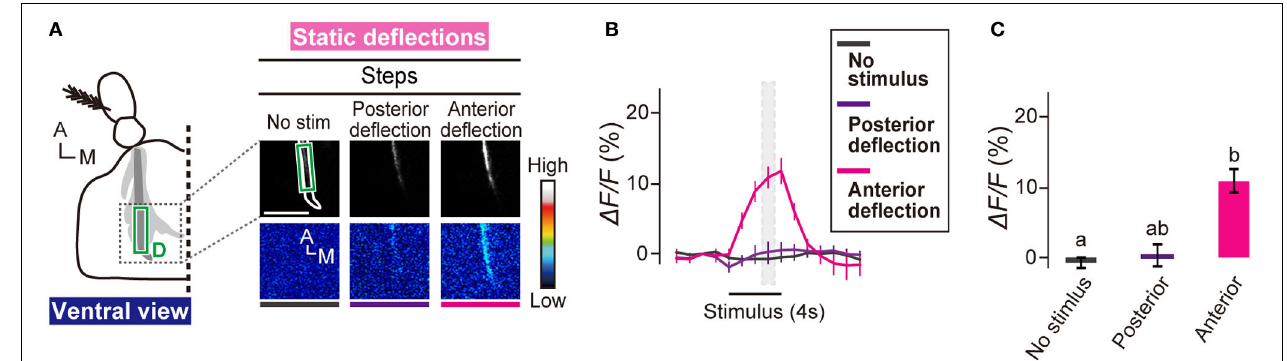
FIGURE 4 | Subgroup-D JO neurons respond to anterior deflection. (A) Calcium response in AMMC zone D to static deflections of the antennal receiver. Scale bar = 25 µ m. (B) Time trace of calcium responses in zone D (green box in panel A ). Gray hatched boxes indicate time-windows for